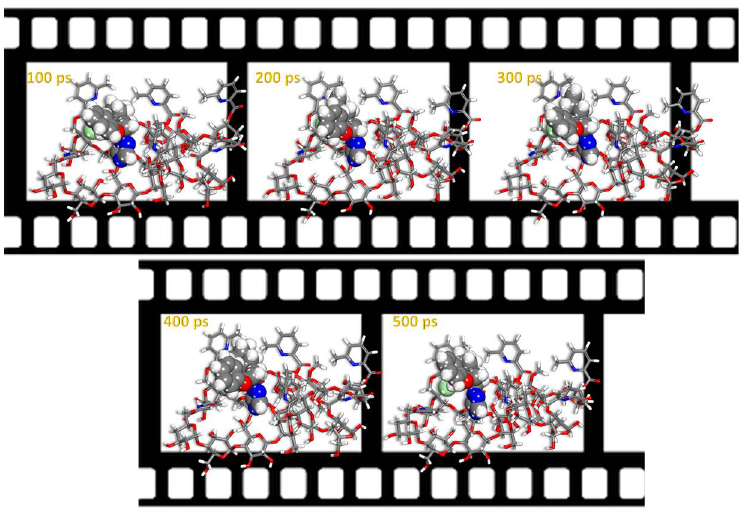
Figure 18. Time-lapse configurations of the interaction of the difenoconazole molecule onto Cell-X surface obtained by